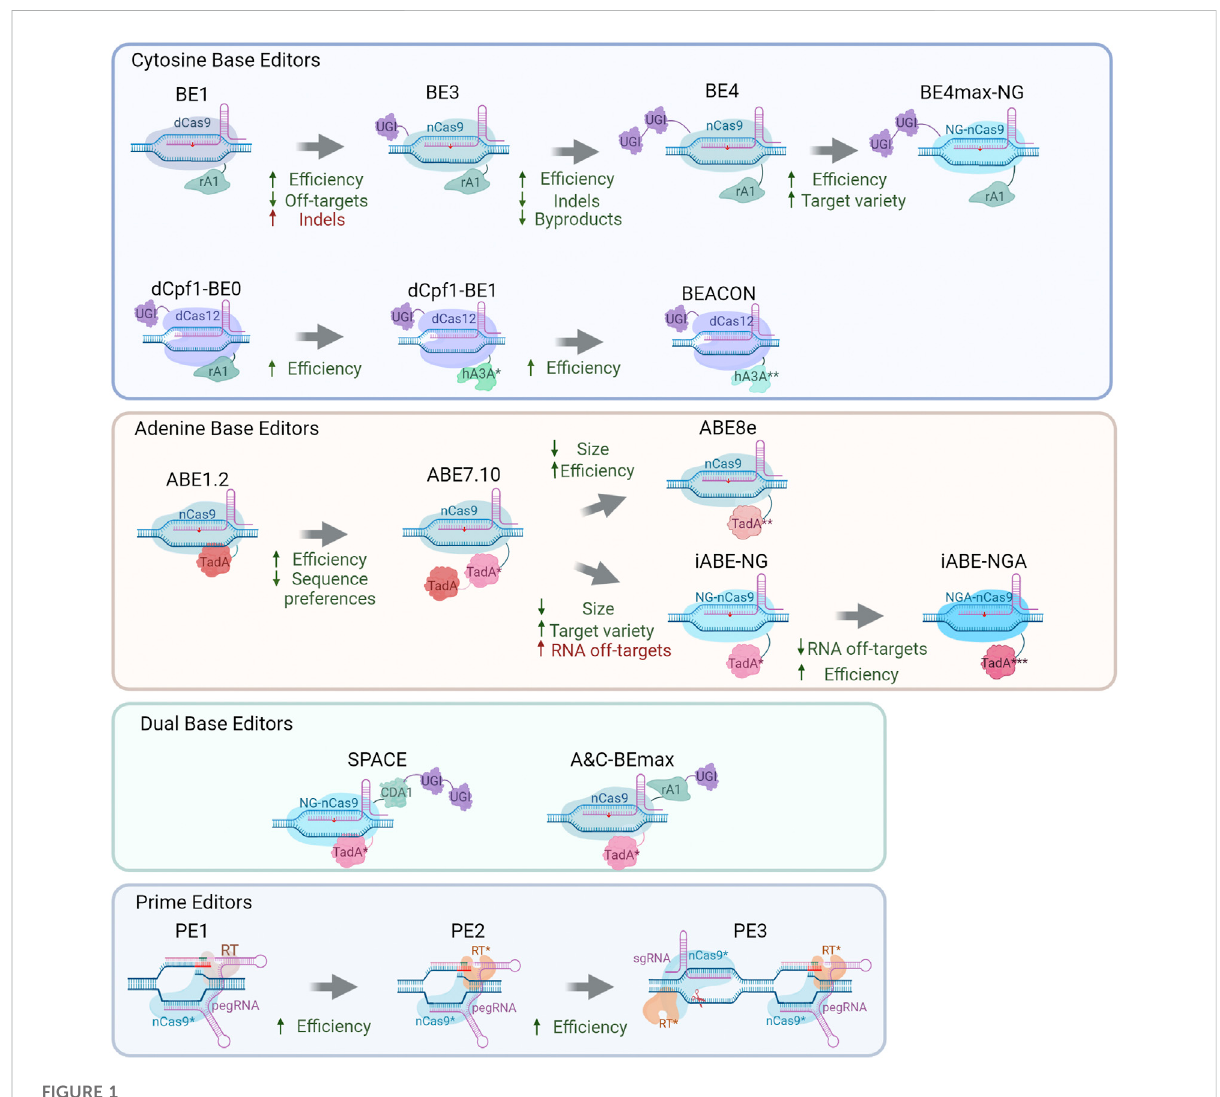
FIGURE 1 | A brief overview of base-editing